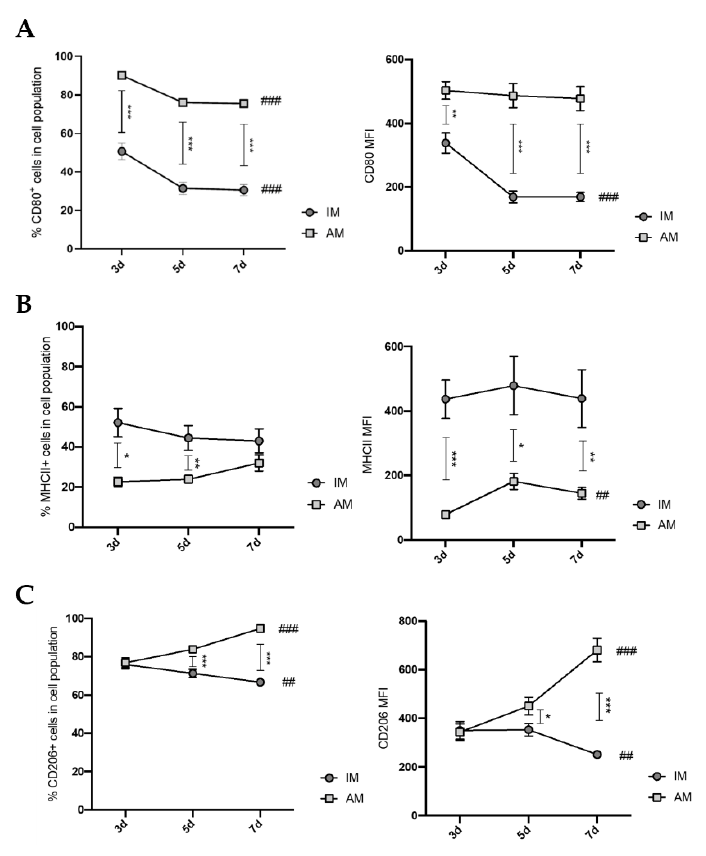
Figure 2. Macrophage populations phenotype in the lung during the inflammatory phase of BLM- induced pulmonary fibrosis mouse model. Expression profile of (A) CD80, (B) MHCII, and (C) CD206 in interstitial- and alveolar-macrophage-treated lungs at days 3, 5, and 7 after BLM administration. The percentage of cells was gated in live CD45 cells. The mean fluorescence intensity (MFI) in the respective macrophage population is plotted in the second graph. The data are represented as the mean ± SEM. * p < 0.05, ** p < 0.01, *** p < 0.001: treated IM vs. treated AM. ## p < 0.01, ### p < 0.001: different time points.